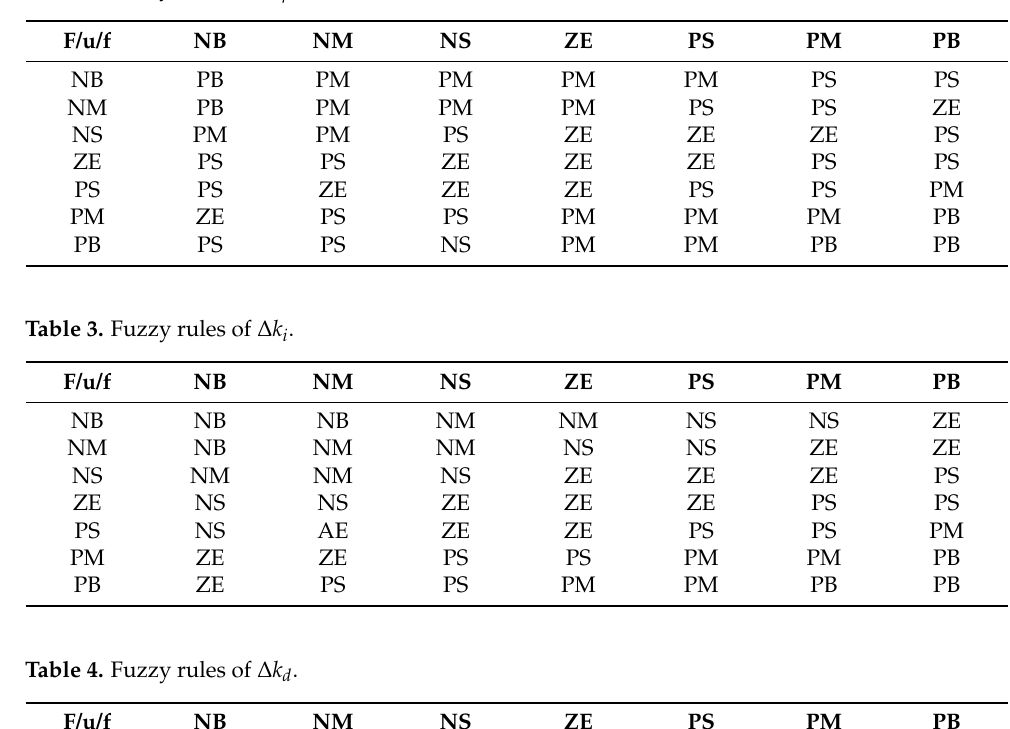
Table 4. Fuzzy rules of ∆ k d .